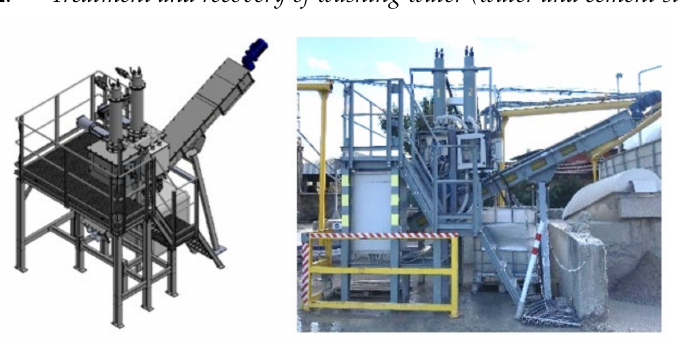
Figure 2. Treatment technology for washing water recovery. Mechanical system equipped with a filter membrane that separates microfiltered water and cement